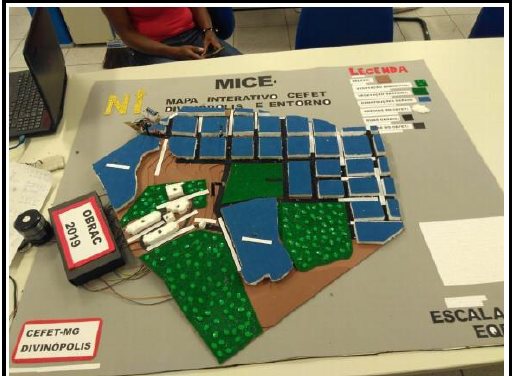
Figure 6. Story Map - We are All Refugees: the story of Wilme Mata 5 .